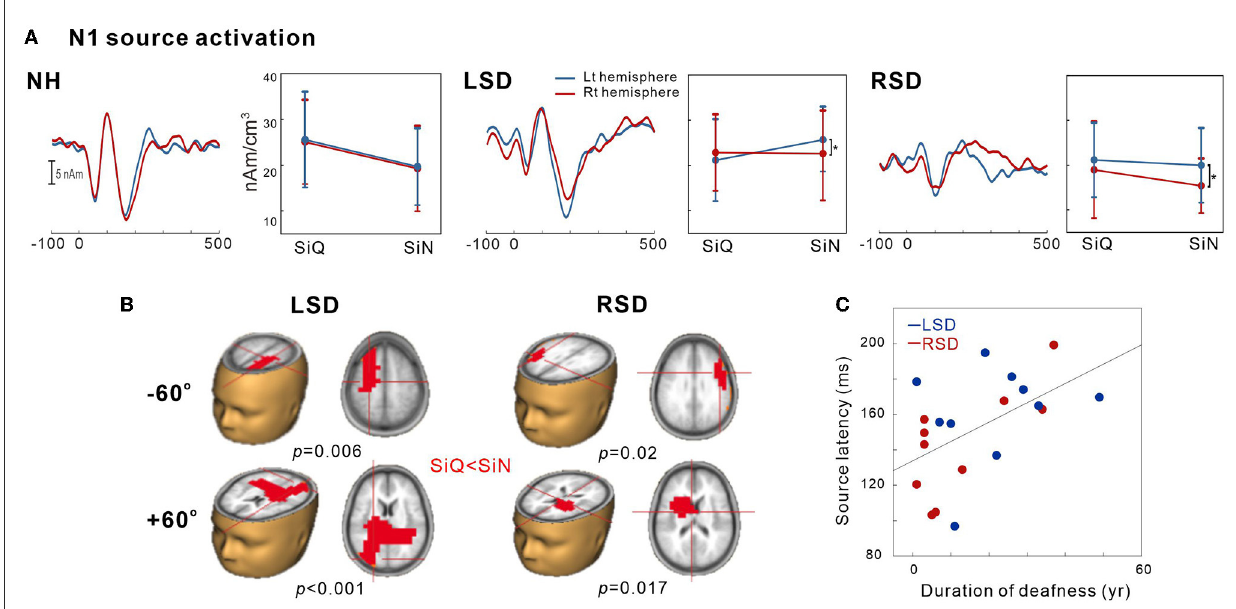
FIGURE4 N1 source activation by the speech-in-quiet (SiQ) and speech-in-noise (SiN) stimuli. (A) The grand mean N1 dipole source waveforms for the left (blue) and the right hemispheres (red) for each subject group. The mean N1 source amplitudes for SiQ and SiN listening are presented for each group on the right side of the mean waveforms. The error bars represent the standard error of the mean. (B) Cluster data representing significant differences between the SiQ and SiN listening tasks in the brain source space. Red indicates that the SiN listening response was larger than for SiQ (a positive difference). Note that these clusters indicate which regions showed a significant difference while the crosshairs indicate a 3D point indicating the maximum difference in the comparison. (C) N1 source latency correlation with duration of deafness. RSD, right-sided single-sided deafness; LSD, left-sided single-sided deafness; NH, normal